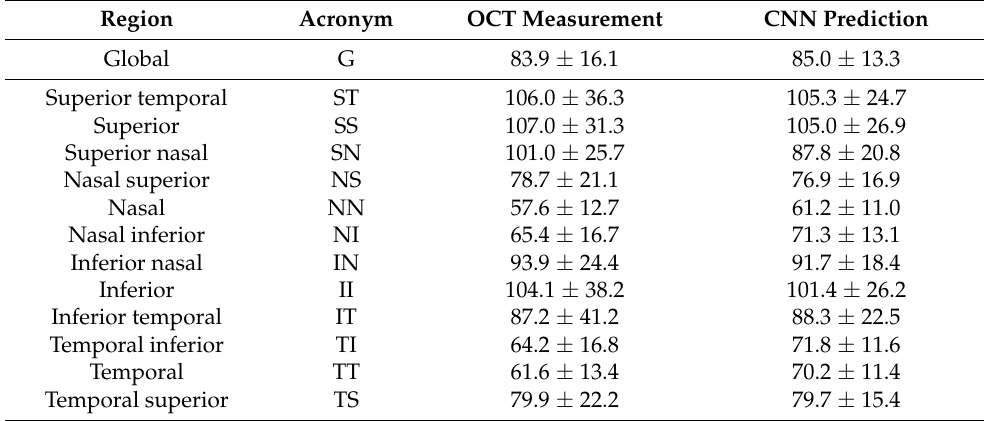
Table 3. The mean and standard deviation of OCT measured and trained CNN prediction on RNFL thickness ( µ m) in the test set along the global and regional